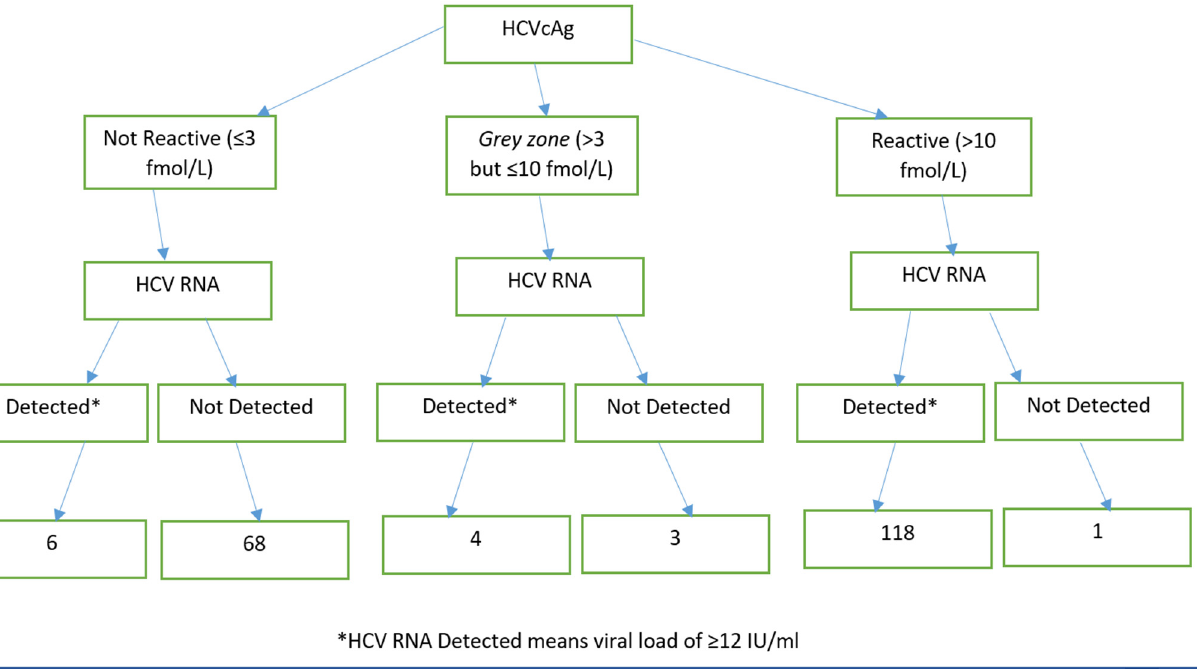
Table 2. Sensitivity and specificity of HCV core antigen plasma ( ≥ 3 fmol/L) compared with differ- ent HCV RNA thresholds.